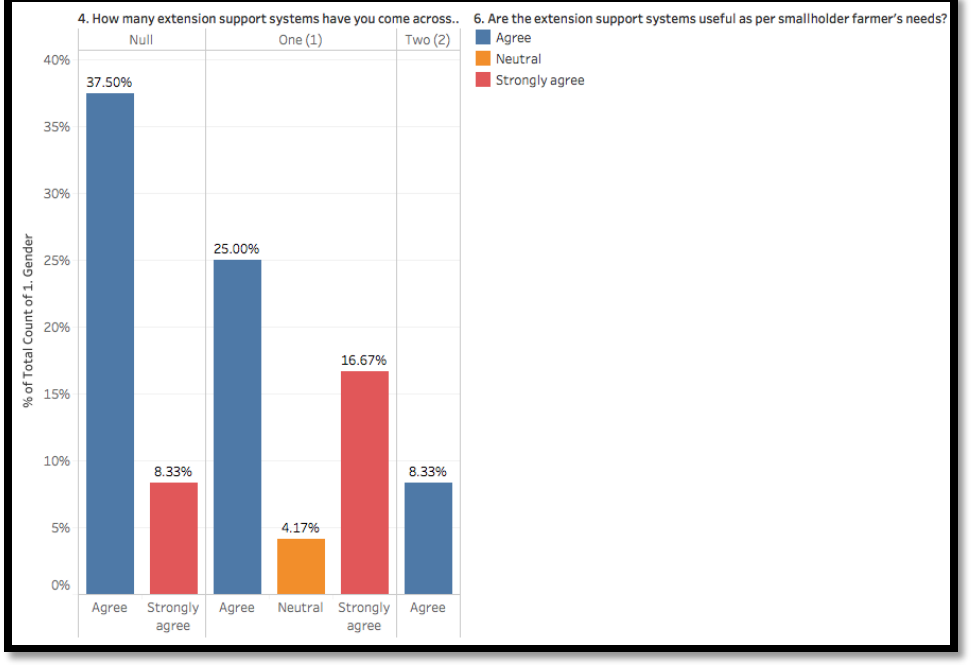
Figure 10. Usefulness and number of extension support system as per agronomist’s